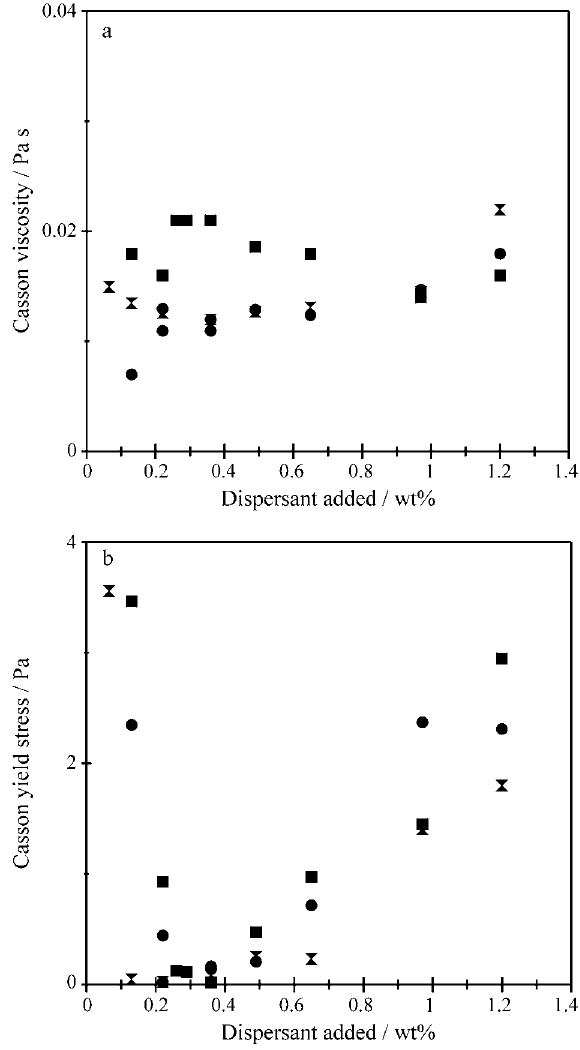
Figure 3. a : viscosity, b : yield stress Casson model parameters (best fit of flow curves of Fig. 1 a, b, and c as a function of the dispersant content for alumina-zircon suspensions of: • stoichiometric, with a 6 wt% excess of alumina and x with a 10 wt% excess of zircon powder mixtures.